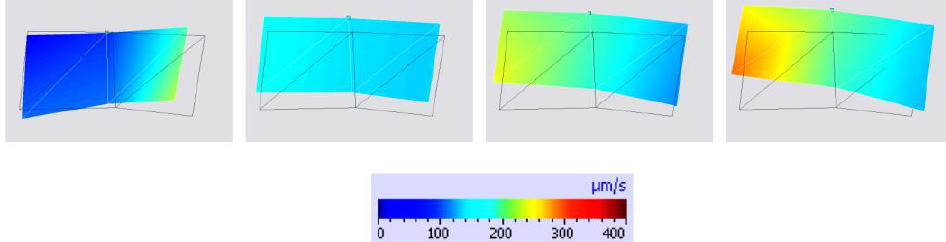
Figure 10. Re-established with PSV Presentation software, distribution of vibration rates over the sample at a frequency equal to the laser irradiation frequency of 100 Hz over the time 0.625 ms [38].